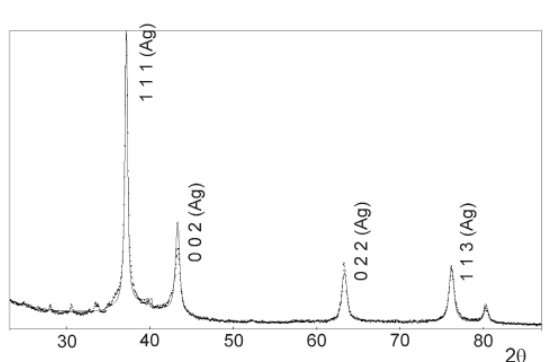
Figure 5. X-ray diffraction pattern (Cu-K a ; Ni – β filter) for deposit after 1 min cementation on magnesium disk from O ) ] 3– 2 3 2